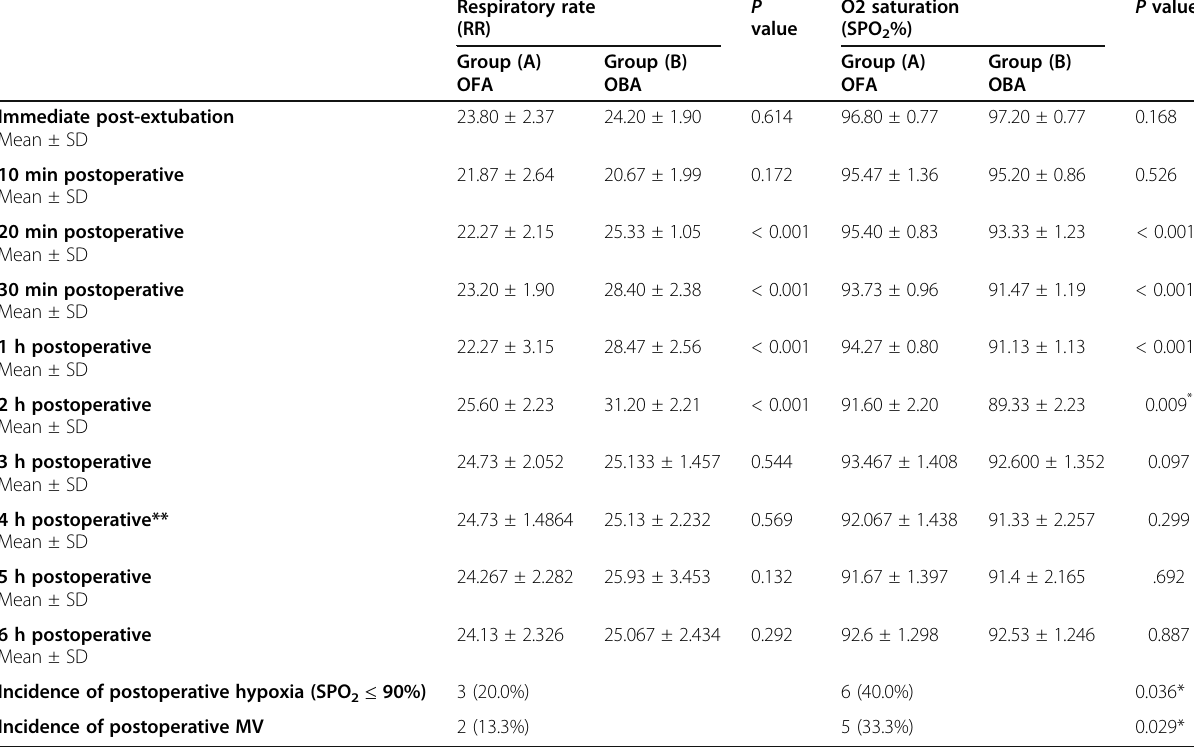
Table 3 Postoperative patients ’ respiratory criteria and the incidence of early postoperative hypoxia and mechanical ventilation within first 6 h postoperatively